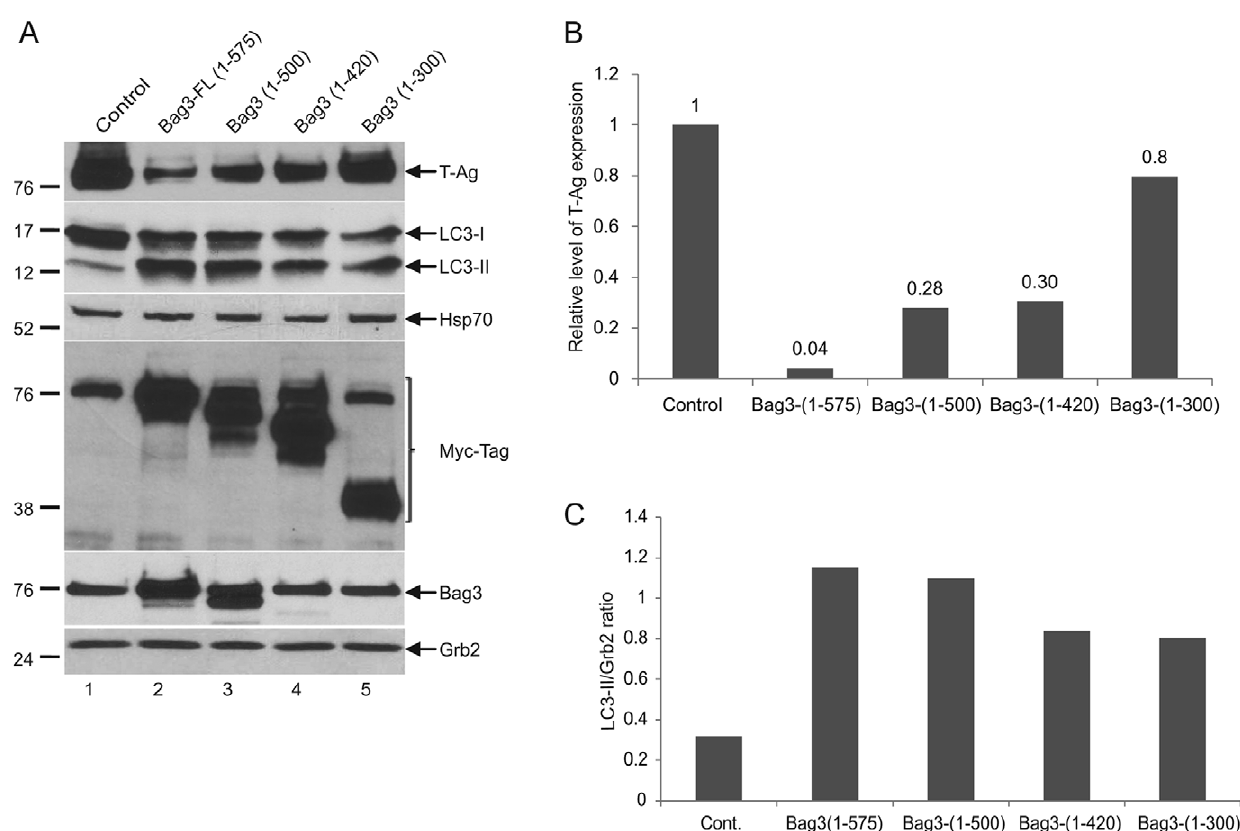
Figure 7. Role of the proline-rich domain of Bag3 in the inhibition of T-Ag. A. Effect of Bag3 mutant proteins on the stabiliy T-Ag. BSB8 cells were transfected with either pCDNA6 Myc-His-Bag3 FL (full-length) expression plasmid (lane 2) or its mutants (lanes 3–6), and after 48 hours, proteins were prepared and analyzed by Western blot using anti-T-Ag, anti-LC3, anti-Hsp70, anti-Bag1, anti-Myc-tag anti-Bag3, and anti-Grb2 antibodies. The control was examination of protein extracts from cells transfected with pCDNA6 Myc-His vector alone (lane 1). B. The relative intensity of the band corresponding to T-Ag from Panel A is shown as a bar graph. C. Relative intensity of LC3-I and LC3-II bands from panel A are determined and LC3-II/ Grb2 ratio is shown as a bar